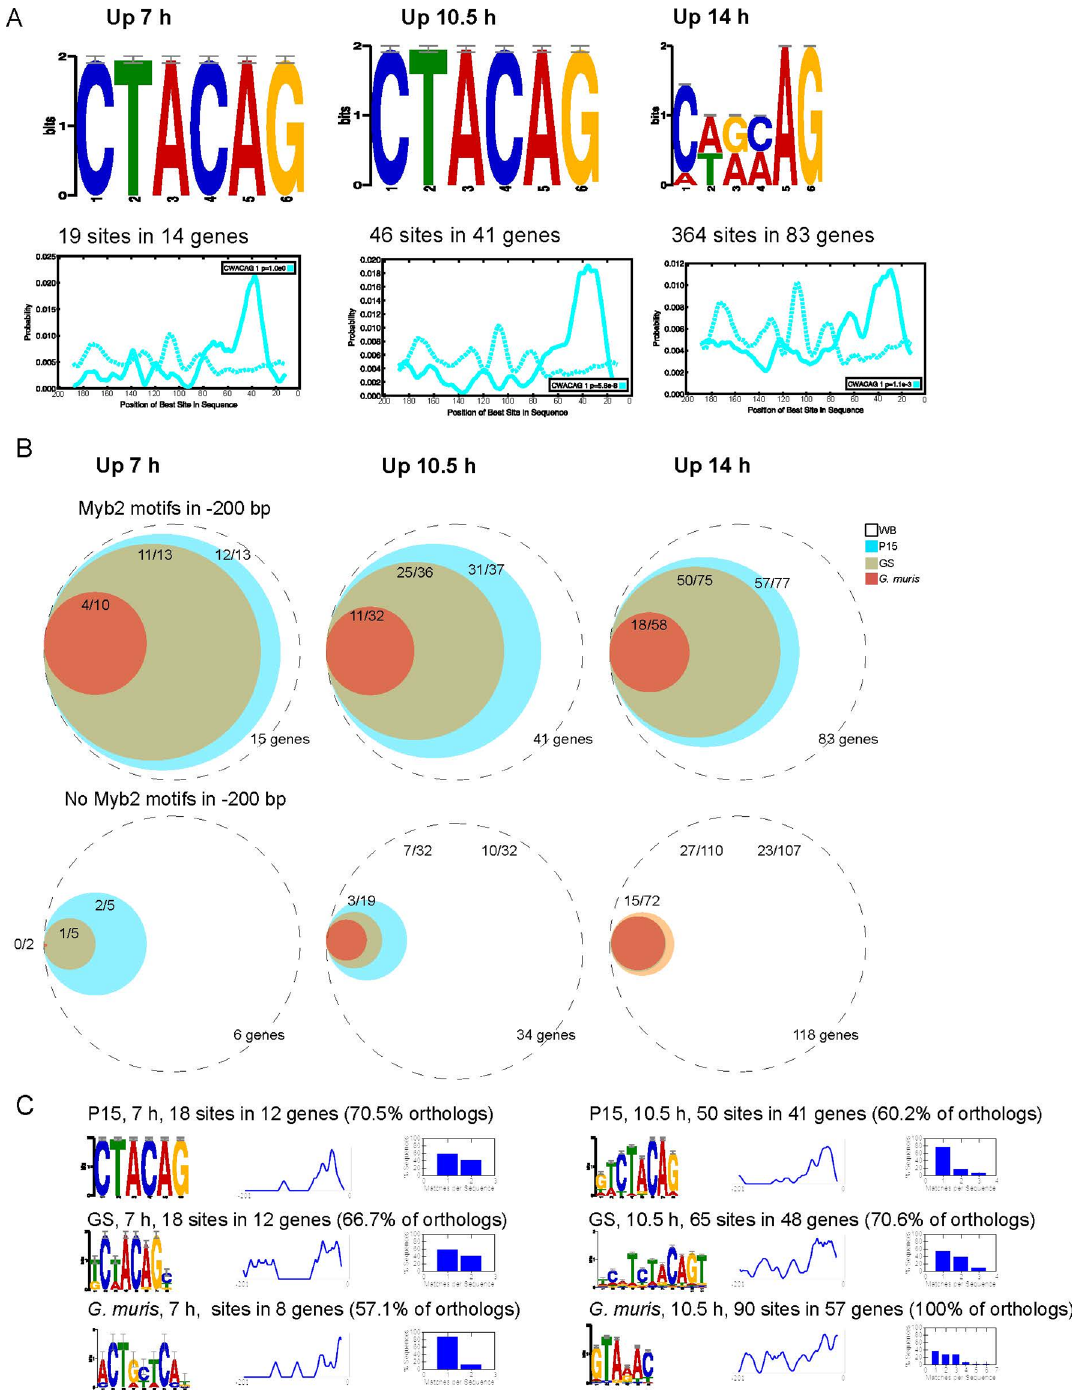
Figure 3. Analysis of Myb2 like motifs. ( A ) Enriched Myb2-like motifs (top panel) and their position in the upstream region (lower panel) of differentially upregulated genes at 7, 10.5, and 14 h p.i. ( B ) Upregulated WB genes with canonical Myb2-sites (CWACAG) are more likely to also have a Myb2-site in the ortholog of assemblage E (P15) (teal), B (GS) (gold), and in G. muris (red). ( C ) De-novo motif finding in the orthologs of upregulated WB genes in assemblage E (P15) (top), B (GS) (middle), and in G. muris (bottom) at 7 and 10.5 h p.i.